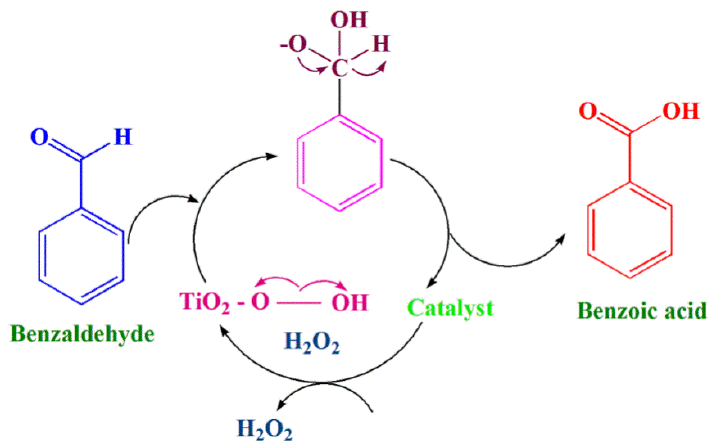
Figure 7. Mechanism of oxidation of benzaldehyde to benzoic acid.